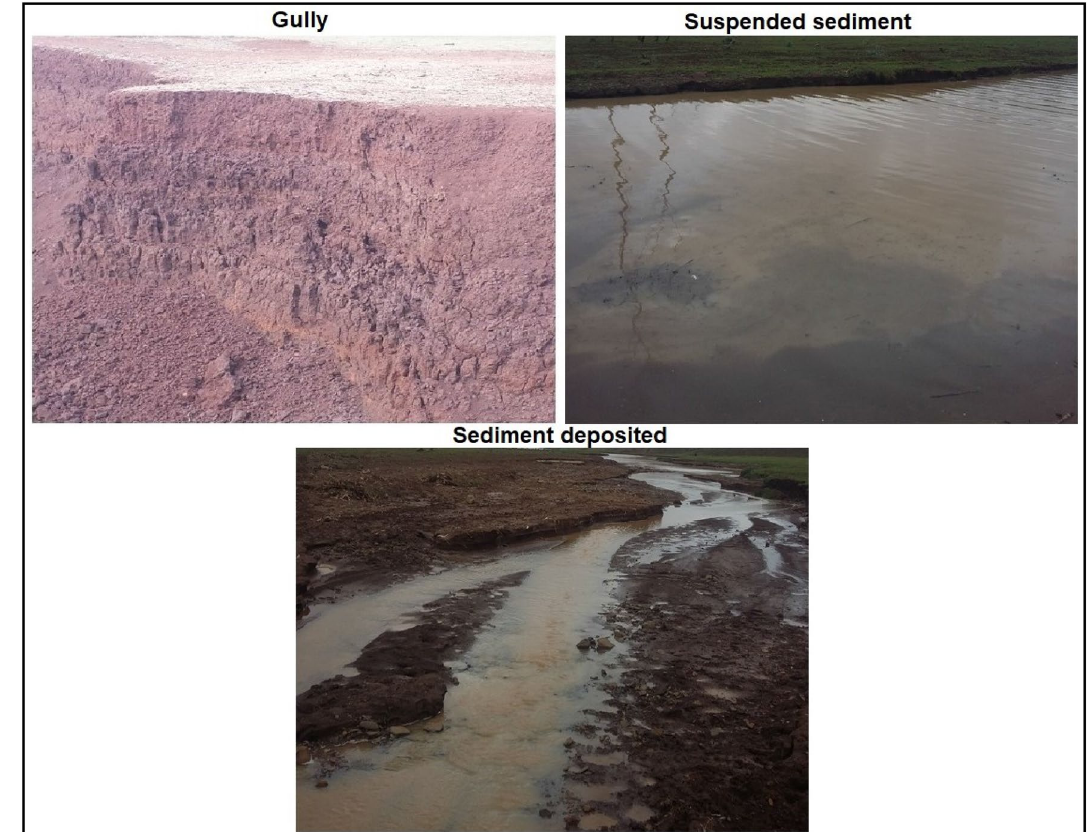
Fig. 7 Figures of deep gully, suspended sediment, and sediment deposition in the